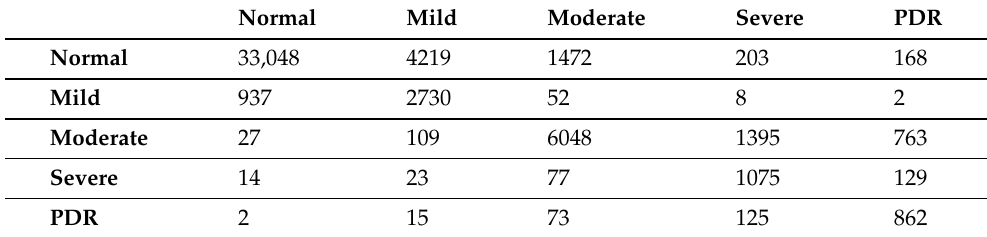
Table 6. Confusion matrix For CNN 1 (Normalized Images), Accuracy = 81.68%.